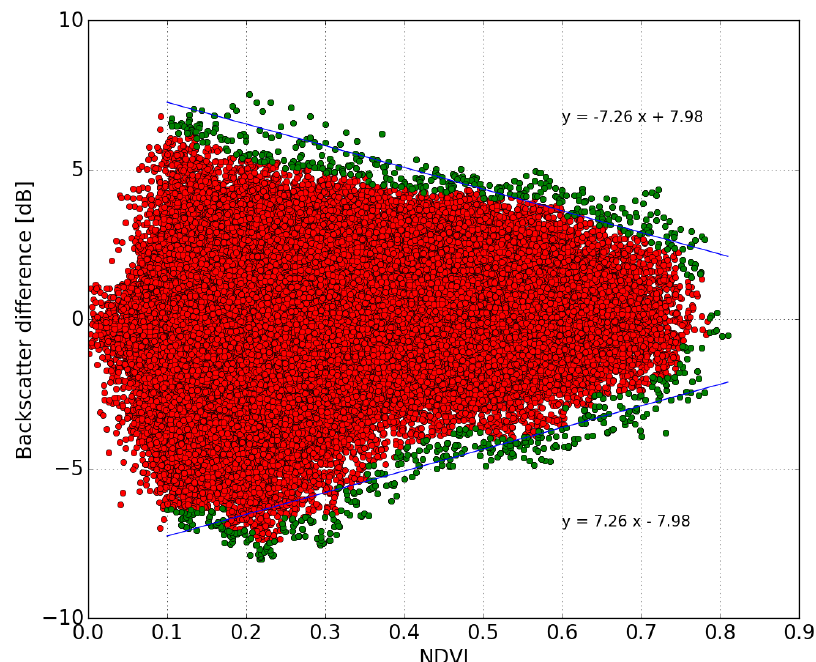
Figure 7. Illustration of the radar signal difference (dB) computed for two consecutive dates, as a function of NDVI over the Urgell site. Each point corresponds to a single cell (i,j). For each value of NDVI, the green points indicate the upper decile of the corresponding differences in radar signal.